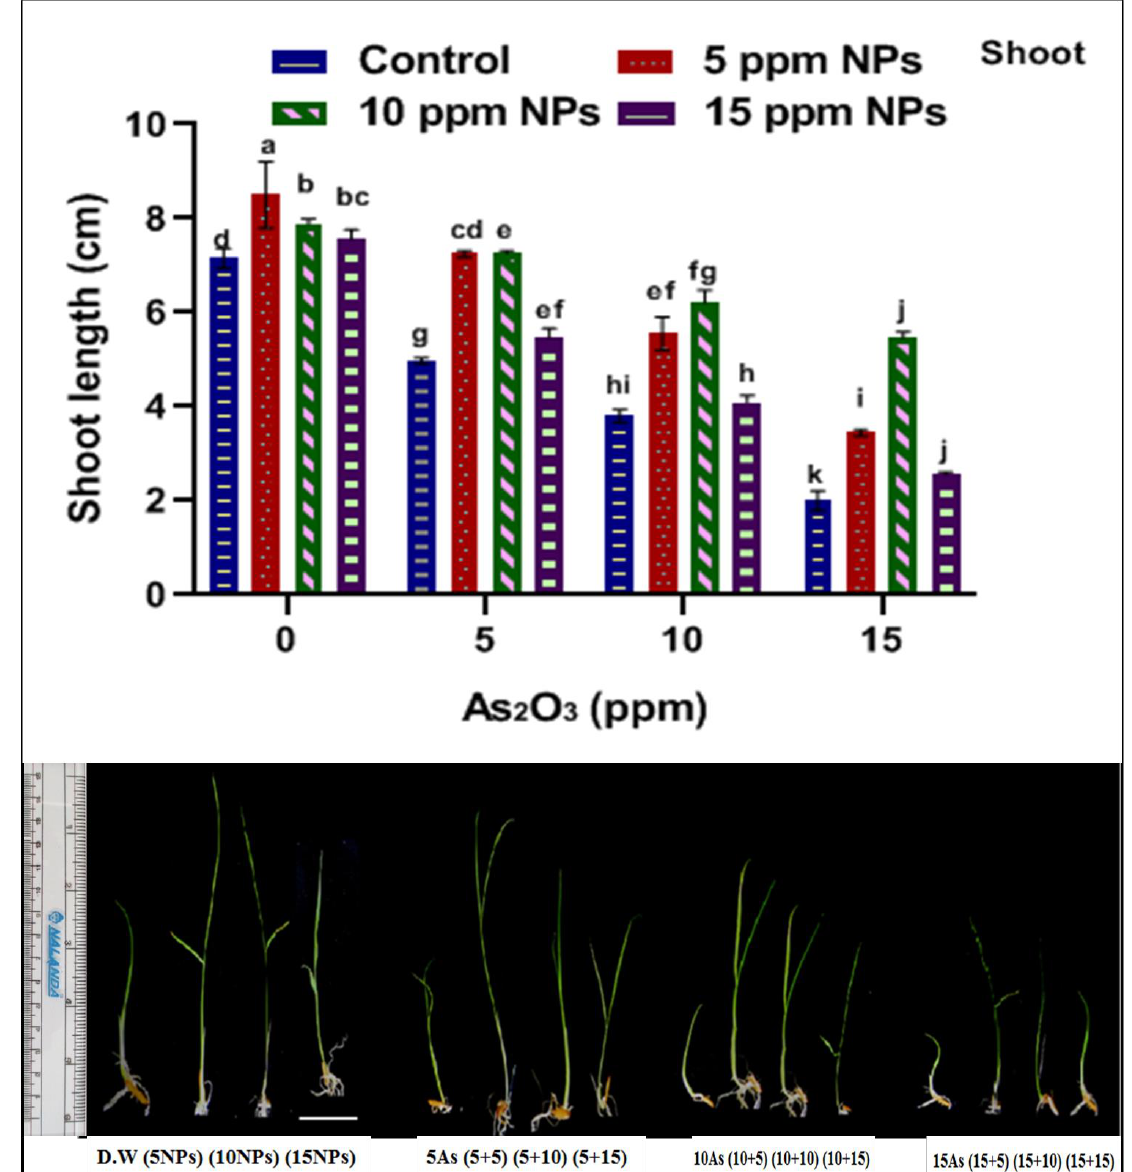
Figure 3. Effect of Bacillus subtilis -synthesized Fe 3 O 4 NPs on shoot length of rice ( Oryza sativa L.) in arsenic-contaminated water. Different letters show a significant difference at p < 0.05 between treatments.